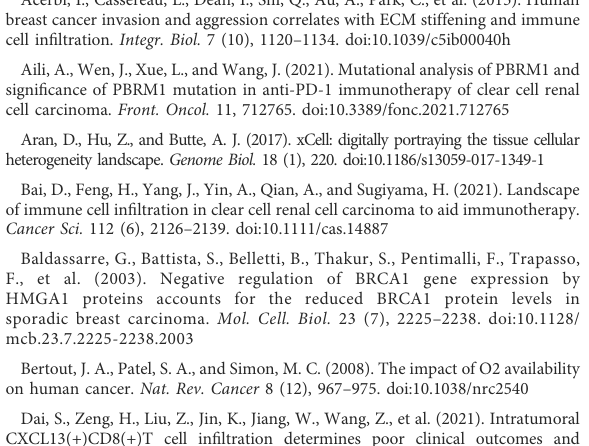
SUPPLEMENTARY FIGURE S1 Veri fi cation of prognostic signi fi cance of these 8 CRlncRNAs. SUPPLEMENTARY FIGURE S2 The correlation between these 8 CRlncRNAs and immune cells. SUPPLEMENTARY FIGURE S3 (A) Difference between high and low risk group. (B) Kaplan – Meier curve of different groups. SUPPLEMENTARY FIGURE S4 Biological Functions of AC093001.1 in 769-P cells (A) . CCK-8 assay was conducted to evaluate whether AC093001.1 knockdown affected the proliferation of 769-P cells. (B) the invasion and migration of different groups of 769-P